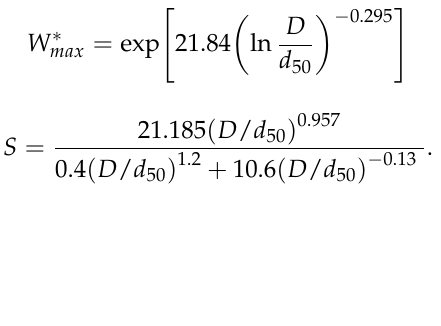
Figure 6. W ∗ max versus D / d 50 values for the filtered dataset in comparison with the fitting function Figure 6. (cid:1849) (cid:1865)(cid:1853)(cid:1876) ∗ versus (cid:1830) (cid:1856) 50 ⁄ values for the filtered dataset in comparison with the fitting function